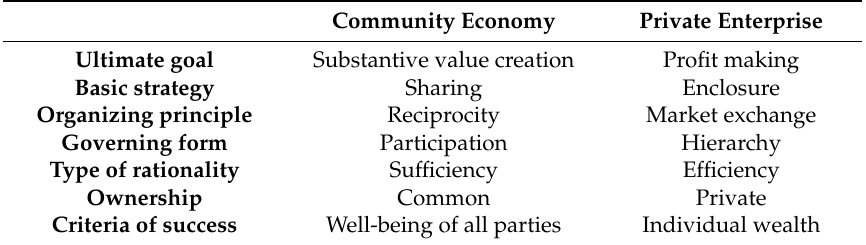
Table 1. Community economy versus private